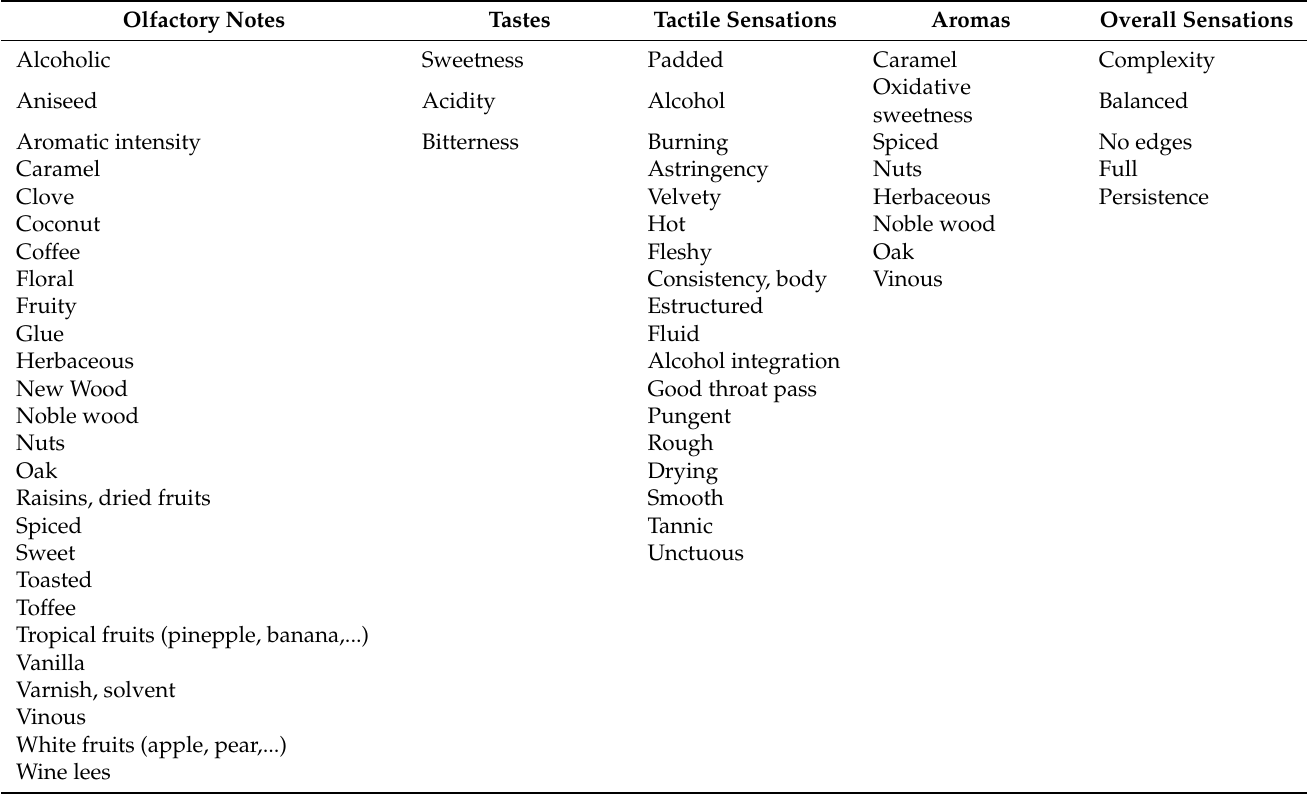
Table 6. List of descriptors resulting from the brainstorming phase and later refined by the panel leader. This list was used as the first step toward the selection of the appropriate descriptors according to the